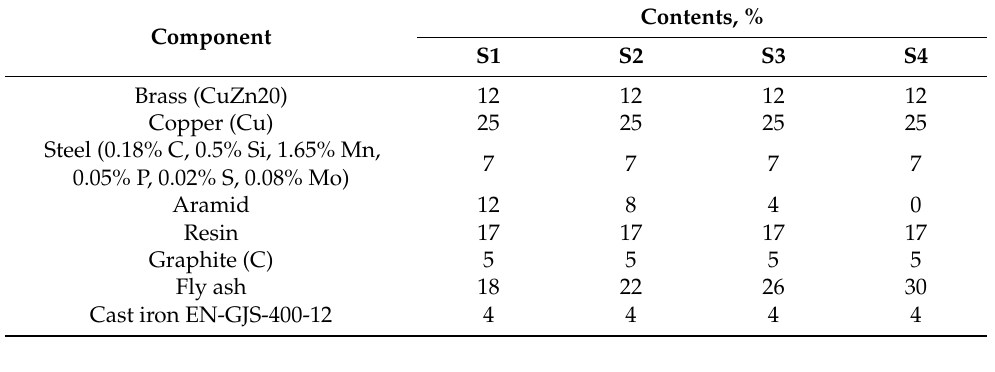
Table 1. Composition of individual groups of samples.